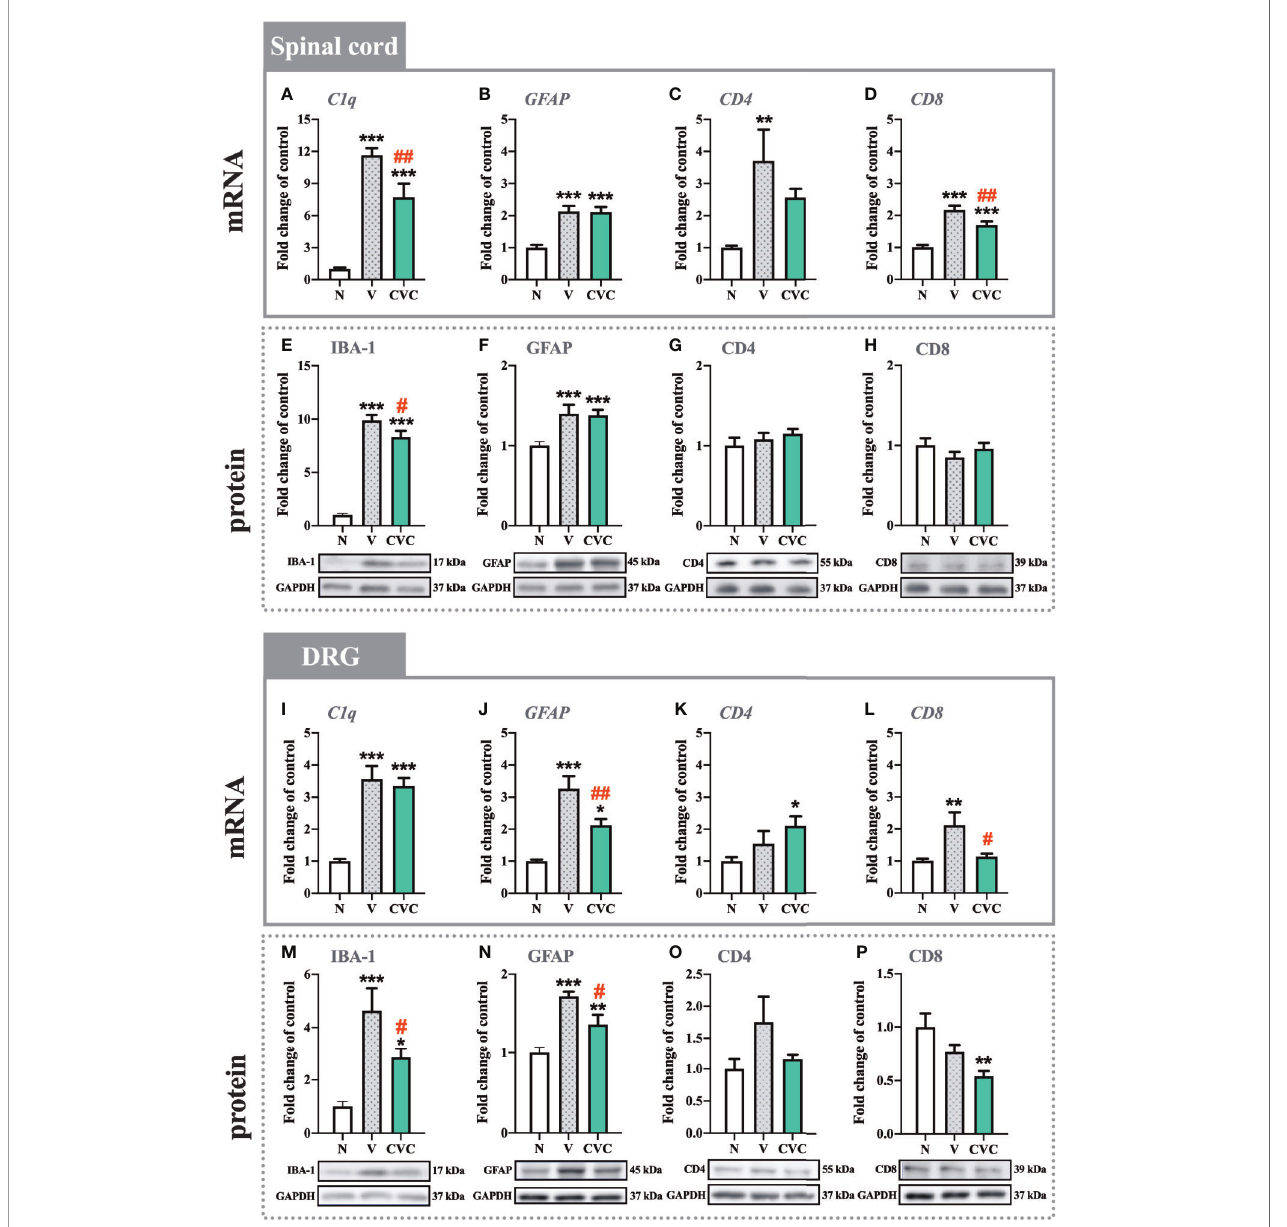
FIGURE 3 | Changes in mRNA (A – D, I – L) and protein (E – H, M – P) levels of C1q /IBA-1, GFAP, CD4, and CD8 in the spinal cord (A – H) and DRG (I – P) on day 7 post CCI, after repeated vehicle or cenicriviroc (20 µg/5 µl, i.t. ) administration, measured using RT-qPCR and Western blot method. Data are presented as the mean ± SEM (n = 4 – 8 per group for mRNA analysis and n = 5 – 9 per group for protein analysis). Intergroup differences were analyzed by ANOVA with Bonferroni ’ s multiple comparisons test. ***p < 0.001, **p < 0.01, and *p < 0.05 indicate differences between naive and V-treated/CVC-treated CCI-exposed rats; ## p < 0.01, # p < 0.05 indicate differences between V-treated and CVC-treated CCI-exposed rats. CCI, chronic constriction injury; CVC, cenicriviroc; N, naive; V,